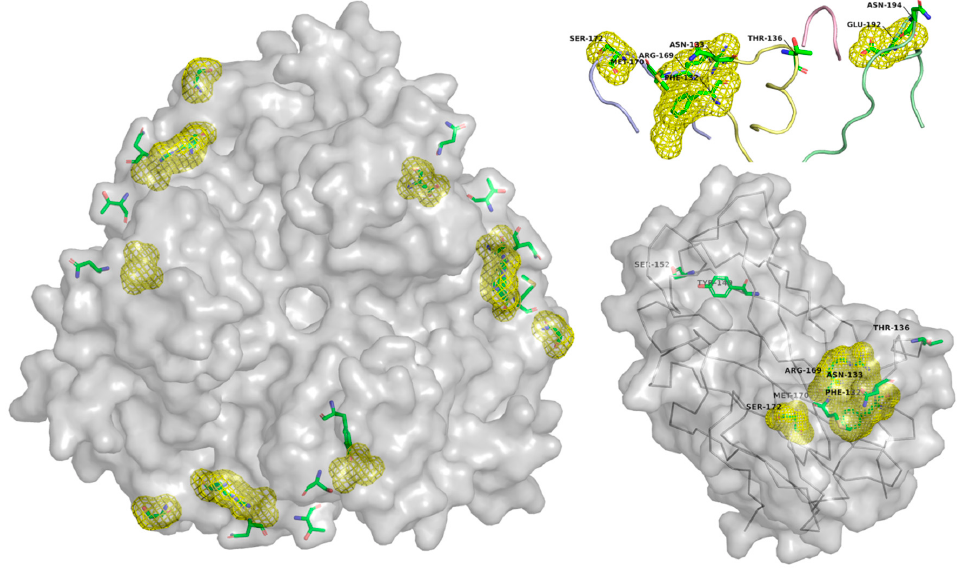
Figure 4. Membrane cofactor (CD46) interacting residues, and known mutation sites, within the Ad35 fiber knob domain: The key residues which interact with CD46 are shown as green sticks. The yellow surface shows the region in which known mutations which abrogate CD46 interaction occur. In the top right is a detailed view of the 4 loops which interact with CD46, HI (blue), DG (yellow), GH (red), and IJ (green). Structure from PDB: 2QLK.